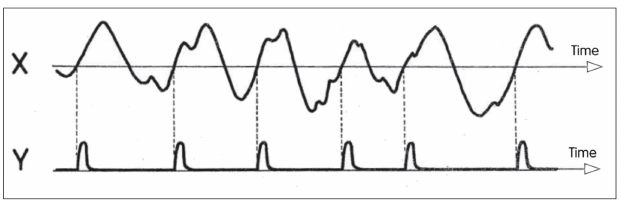
Figure 24. Another use of the pulse sharper from Figure 22. The output pulse generated in the output Y identifies the instants at which the increasing input flow in X crosses the zero.